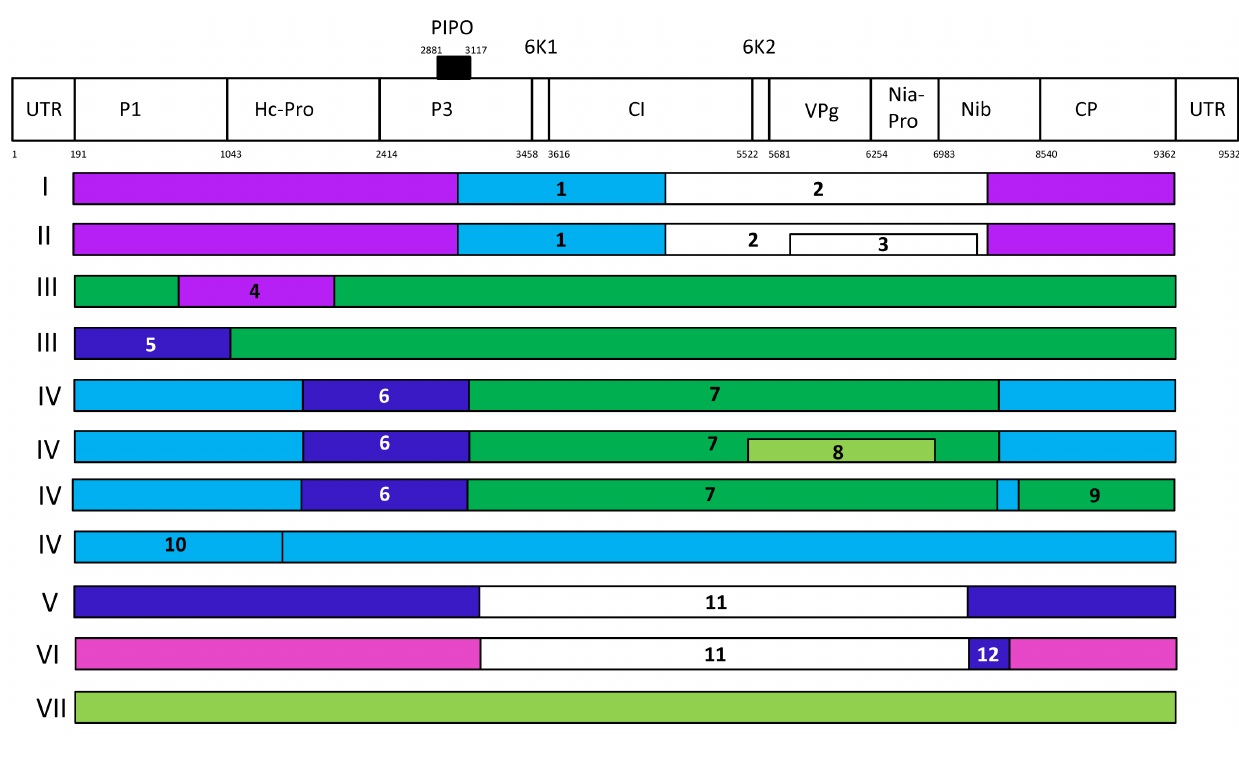
Figure 1. Recombination events between the coding regions of 33 Beanyellowmosaicvirus (BYMV) and two from Cloveryellowvein virus (ClYVV) genomes. The locations of genes in the BYMV genome are indicated by the diagram at the top of the Figure. Twelve recombination events were found, labeled 1–12. Each recombination event correlates with the event column in Table 2. Each color represents a phylogenetic group, apart from purple, which represents two such groups, I and II. The phylogenetic groupings of Kehoe et al. 2014a are indicated at the left hand side of the picture. The colour of each event refers to the phylogenetic grouping of its predicted parental sequences, which are detailed within Table 2. The white colour represents events whose parental sequences are unknown. The sequences analyzed were: HG970847, HG970851, HG970852, HG970860, HG970861, HG970865, HG970869, FJ492961 and JX173278 (Phylogenetic group I); HG970850, HG97054, HG970855, HG970858, HG970859, HG970863 and JX156423 (II); AB079886, AB079887 and AB439729 (III); D83749, AM884180 and AY192568 (IV); AB439732 and U47033 (V); HG970866 and HG970868 (VI); AB439731 and HG970867 (VII); DQ641248 (VIII); AB373203 (IX); NC003536 and HG970870 (ClYVV). No recombination events were detected in sequences from phylogenetic groups VII–IX or within ClYVV, but a sequence from group VII is suggested as a parental sequence for one of those from group IV.